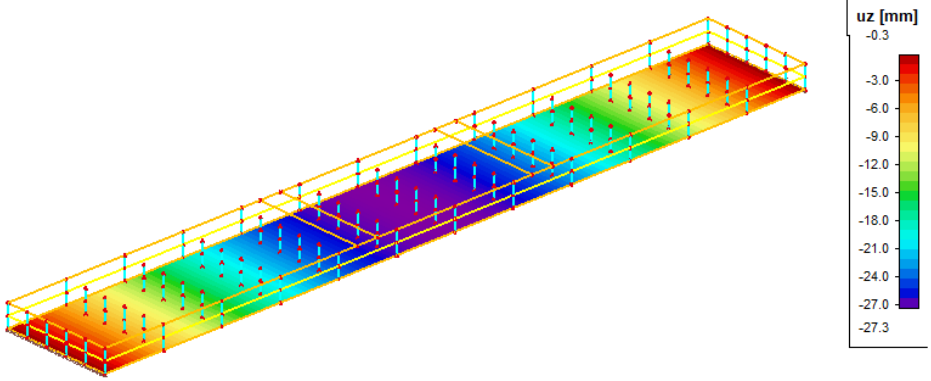
Figure 9. Deflection area of the numerical model in SCIA Engineer.